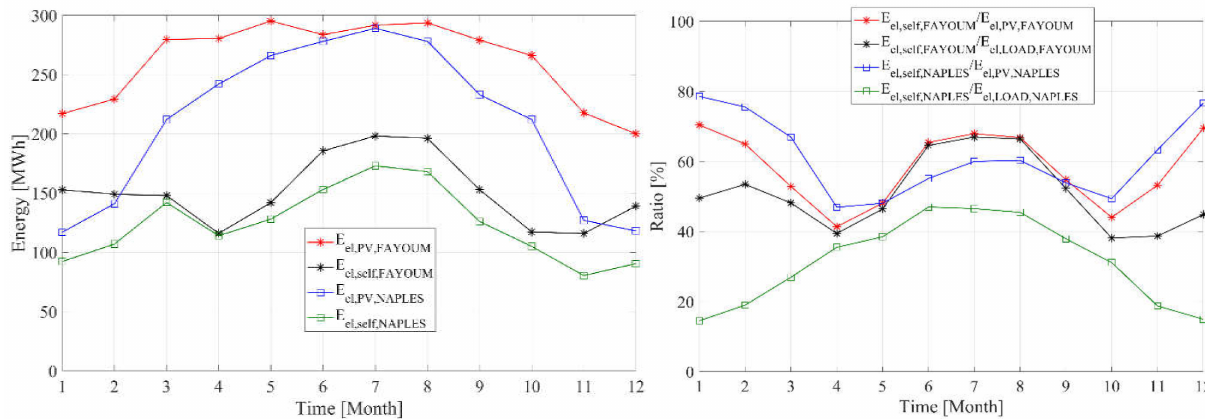
Figure 12. Renewable layout differences between Fayoum and